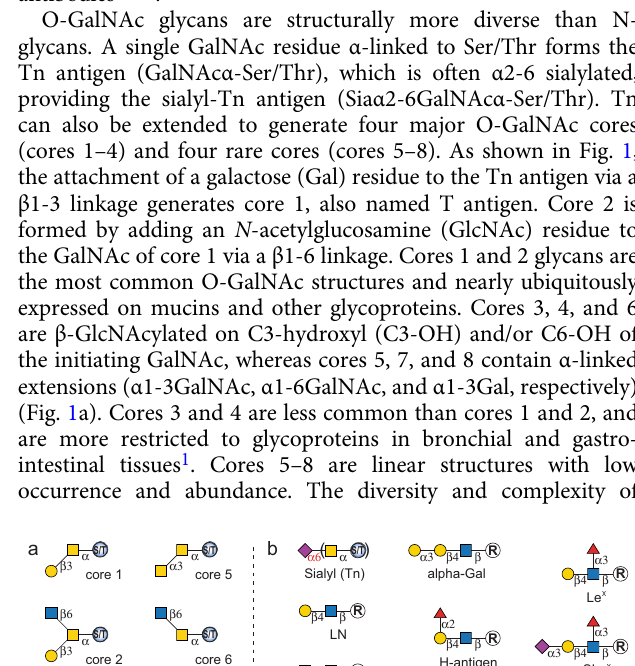
Fig. 1 Structures of O-GalNAc glycan cores and their common glycan epitope extensions. a O-GalNAc glycan cores 1 – 8. b Common glycan epitopes found on O-GalNAc glycans. LN, N -acetyllactosamine (LacNAc); LDN, N , N ’ -diacetyllactosamine (LacdiNAc); 3SLN, 3 ’ -sialyl LacNAc; 6SLN, 6 ’ -sialyl LacNAc; Le X , Lewis X; SLe X , sialyl-Lewis X; Le Y , Lewis